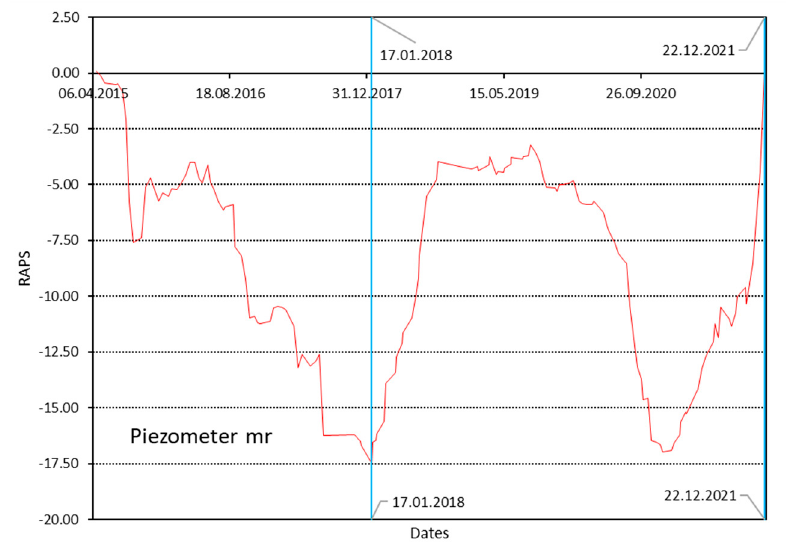
Figure 16. RAPS values for piezometer PR2/1.